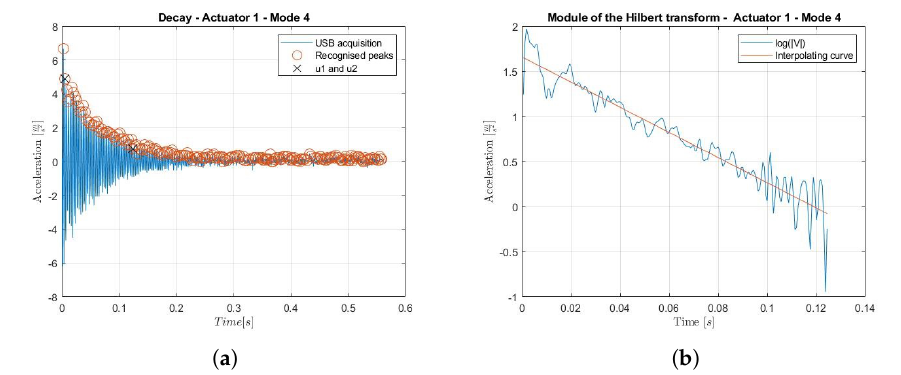
Figure 6. Vibration decay of mode 4 observed by Actuator 1 ( a ) and Hilbert transform modulus and the interpolating function ( b ).